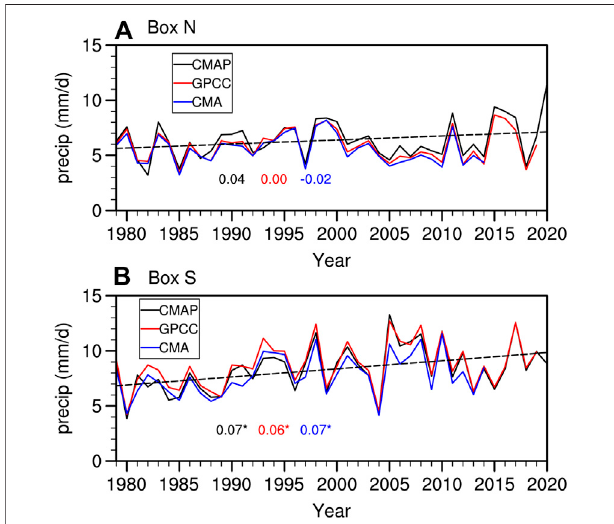
FIGURE3| Time seriesoftheJunerainfallduring1979 – 2020fromthree precipitation observations (CMAP, GCPP, and CMA station observations). The area-weighted mean rainfall over (A) the north box and (B) the south box in Figures 2D – F is focused. The trend in each dataset is printed, and an asterisk is added if the trend (units; mm/d/yr) is signi fi cant at the 95% con fi dence level.